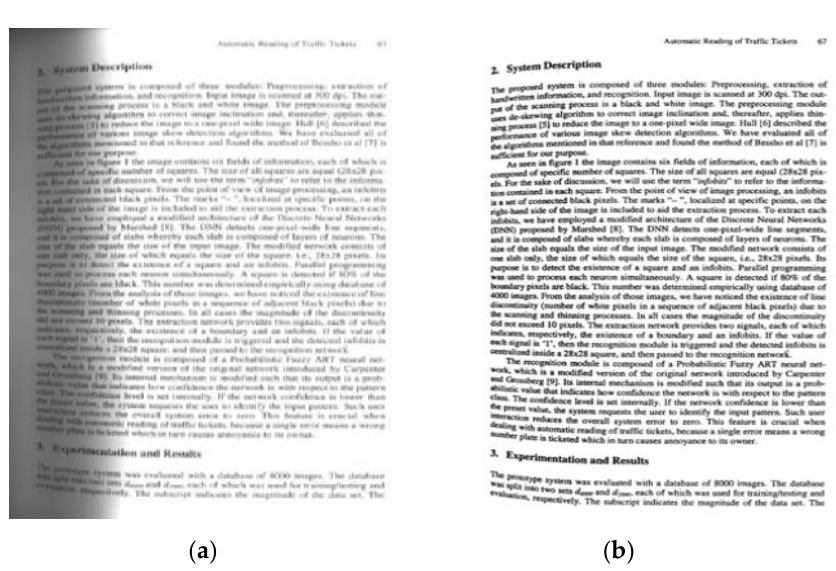
Figure 3. Two images of the same document before ( a ) and after ( b ) illumination removal.